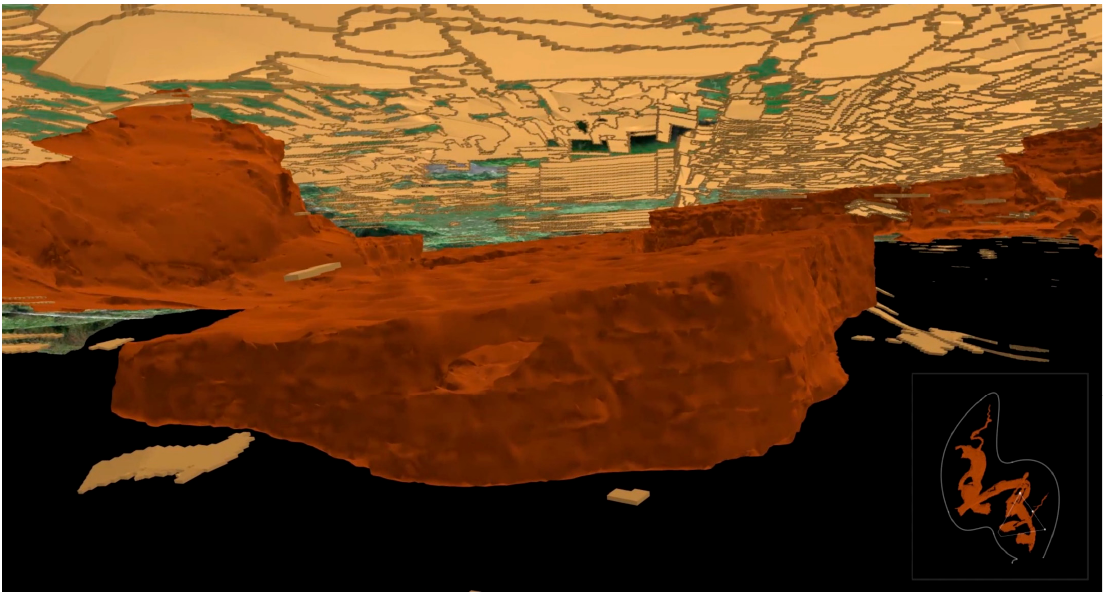
Figure 18. Image of integrating the UAV model, 3DTLS and GPR (100 MHz antenna), showing the discontinuities in the Polychrome overlying layer (in light brown) and the backside of the Polychrome Hall (in dark brown).